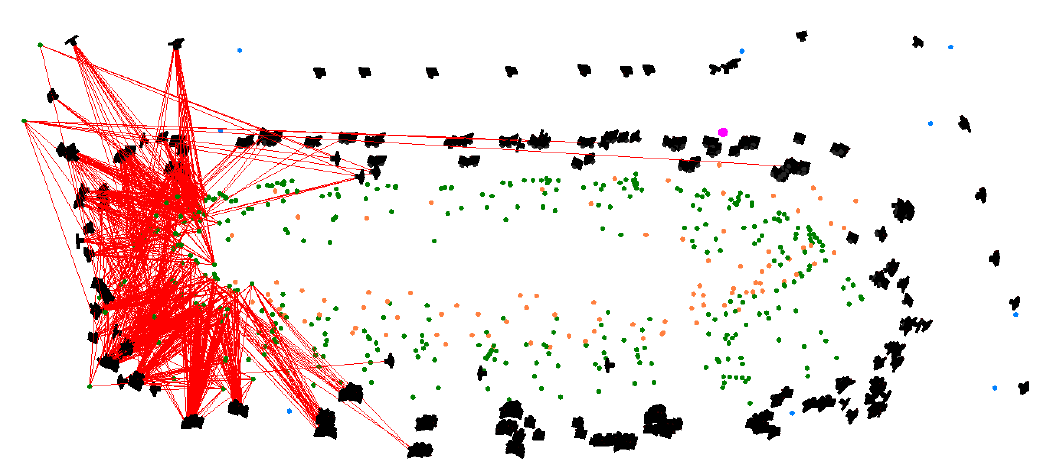
Figure 9. Principal acquisition scheme for large volume environment (green: object points, orange: points on Cog; red: exemplary image rays to object points, blue: control points)